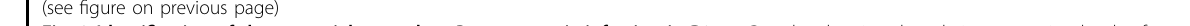
Fig. 3 Identi fi cation of the potential secondary B. cenocepacia infection in P01. a Bar plot showing the relative expression levels of nonviral microbes in all specimens from P01. A timeline chart showing the corresponding changes in abundance of B. cenocepacia transcripts from 27 January to 07 February 2020 in P01. Brown indicates throat swabs; orange indicates nasal swabs and green indicates GIT samples including anal swabs and feces. A total of 11 specimens from the respiratory tract (RT) and gastrointestinal tract (GIT) are shown. Orange, fungi; blue, bacteria. b Heatmap showing the relative expression levels of virulence factors of B. cenocepacia . A total of 50 identi fi ed virulence genes are shown and ranked according to their functional categories: light blue, resistance to stress conditions; blue, antimicrobial resistance; light green, fl agella and cable pilus; green, lipopolysaccharide; pink, exopolysaccharide; orange, iron uptake; light purple, quorum sensing; purple, genes located in a pathogenicity